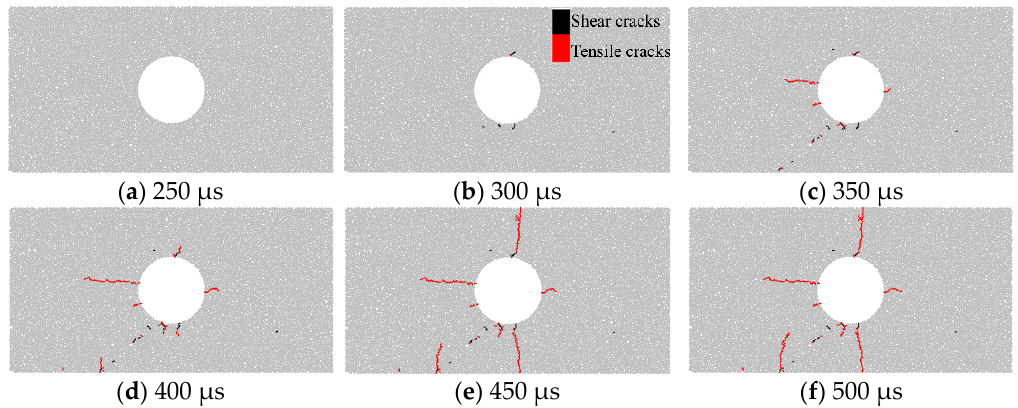
Figure 10. Evolution of cracks around the